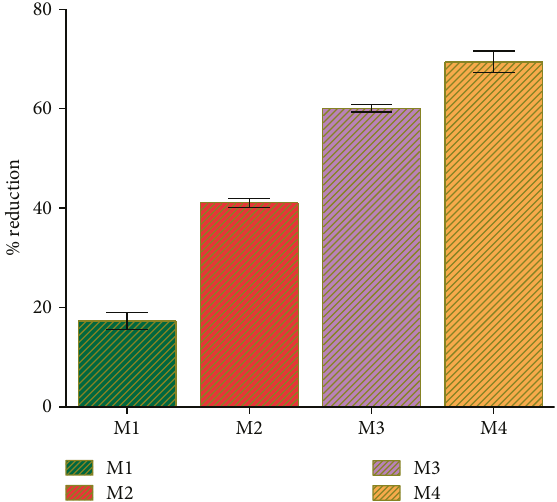
Figure 10: Antibacterial activity of various fabricated membranes against S. typhi